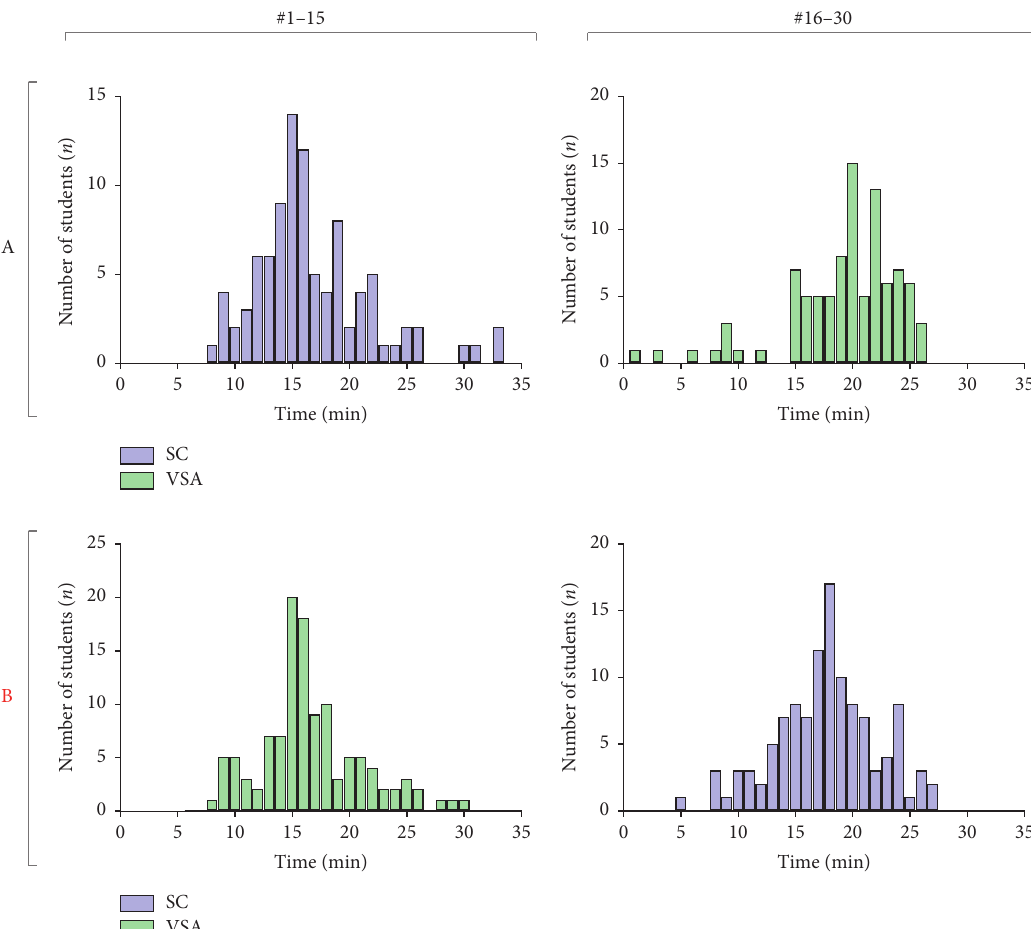
Figure 3: Distribution of times for working on a test in group A-SC (#1–15), in group A-VSA (#16–30), in group B-VSA (#1–15), and in group B-SC